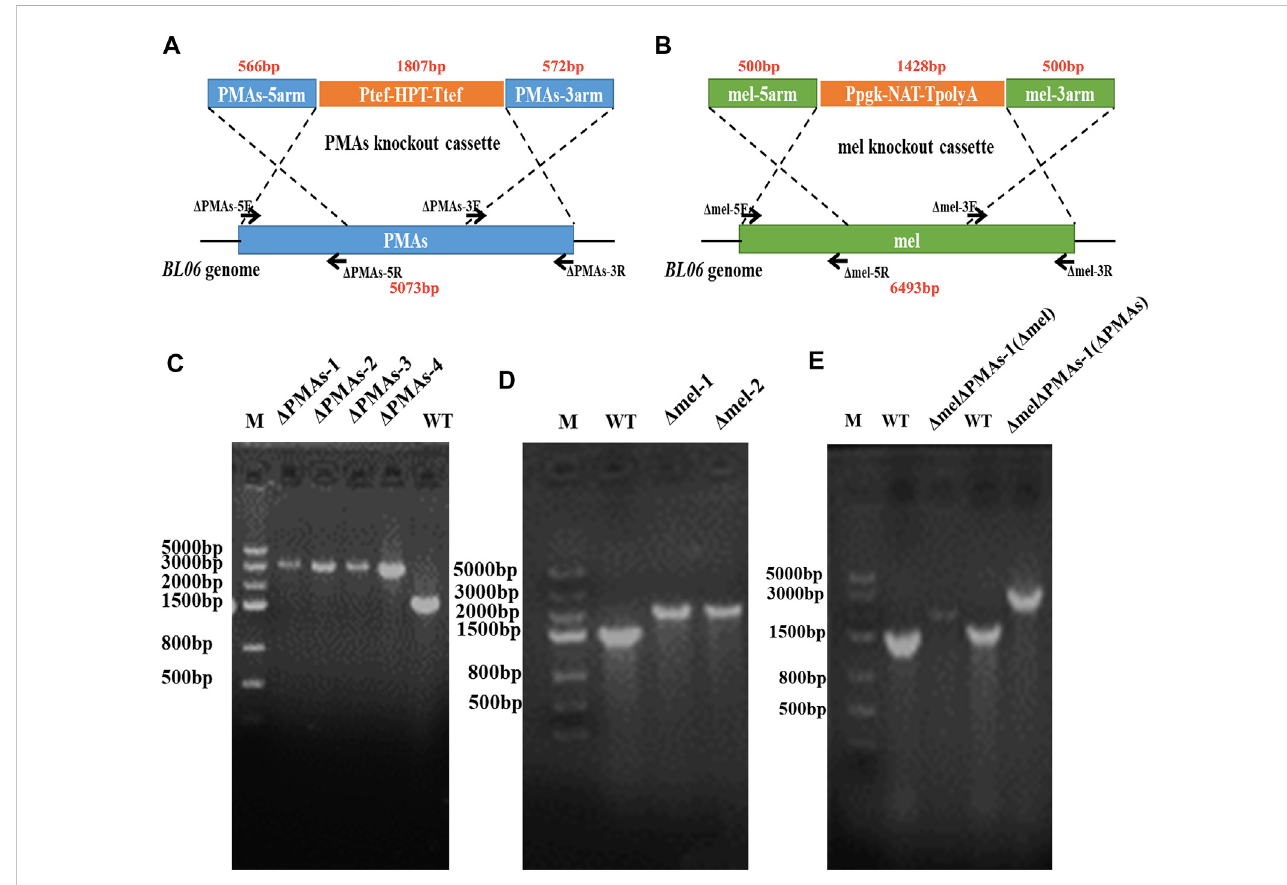
FIGURE 3 Construction of engineered strains for gene knockout. (A) Schematic diagram of gene knockout of PMAs in the genome of A. pullulans BL06; (B) Schematic diagram of gene knockout of melanin in the genome of A. pullulans BL06; (C) Identi fi cation of the positive transformants for A. pullulans BL06 Δ PMAs by PCR; (D) Identi fi cation of the positive transformants for A. pullulans BL06 Δ mel by PCR; (E) Identi fi cation of the positive transformants for A. pullulans BL06 Δ PMAs Δ mel by PCR.